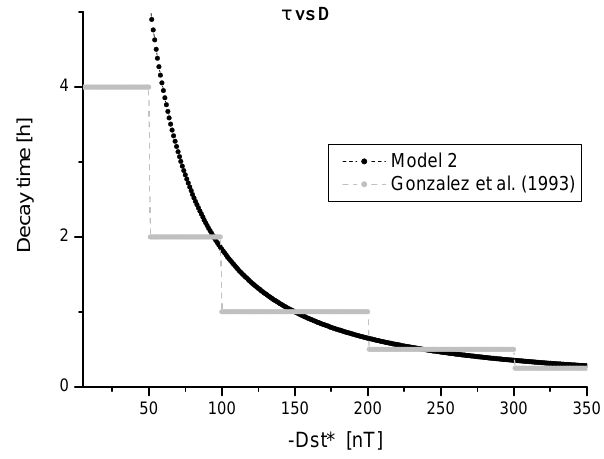
Fig. 1. Two models of the decay time of particles in terms of D st . Comparison between our approach (Model 2) and the refined model of Gonzalez et al.